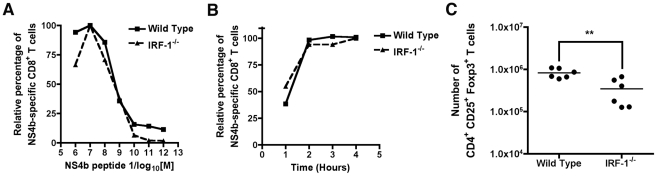
Mechanism of selective expansion of WNV-specific CD8+ T cells in IRF-1
-/- mice.
A. Assessment of CD8+ T cell avidity. Ex vivo restimulation of CD8+ T cells from wild type or IRF-1
-/- mice was performed over the indicated range of NS4b peptide concentrations. Cells were stained for CD3, CD8b, and intracellular IFN-γ, and analyzed by flow cytometry. The data are normalized relative to the peak percentage of cells expressing IFN-γ (for wild type (∼5%) or IRF-1
-/- (∼30%)) after incubation with NS4b peptide (10-7 M). Data were generated from two independent experiments with 6 to 8 wild type or IRF-1
-/- mice in total. B. Kinetics of CD8+ T cell induction. Wild type or IRF-1
-/- CD8+ T cells from WNV-infected mice were harvested at day 8 and restimulated ex vivo with NS4b peptide (10-7 M) for the indicated times. Cells were stained for CD3, CD8b, and intracellular IFN-γ, and analyzed by flow cytometry. The data are normalized relative to the peak percentage of cells expressing IFN-γ (for wild type (∼5%) or IRF-1
-/- (30%) after incubation with NS4b peptide (6 hour time point). Data were generated two independent experiments with 6 to 8 wild type or IRF-1
-/- mice in total. C. Treg analysis in WNV-infected wild type or IRF-1
-/- mice. At day 8, spleens were harvested and analyzed for the number of Treg using antibodies to CD4, CD25, and FoxP3. Data are displayed as a scatterplot and reflect six individual wild type or IRF-1
-/- mice from two independent experiments. Asterisks indicate values that are statistically different.